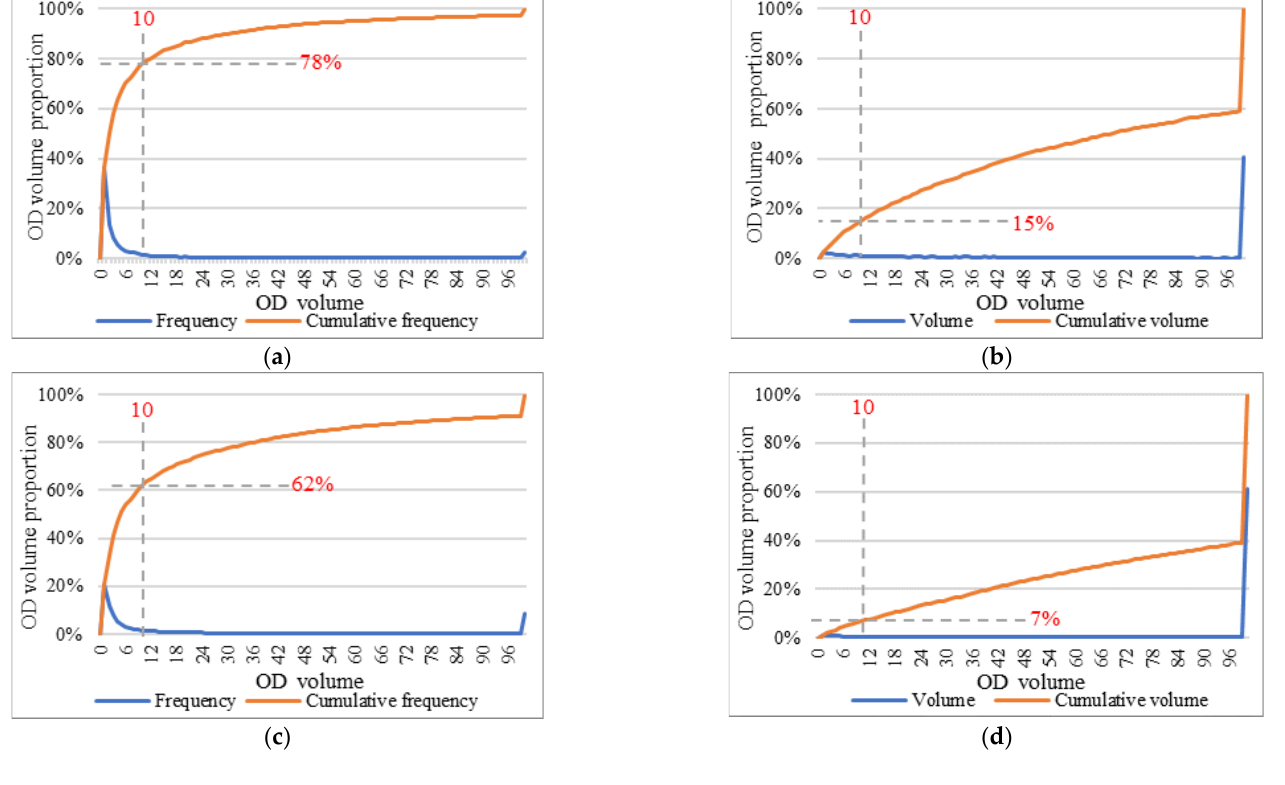
Figure 8. Distribution of taxi travel flow volume. ( a ) OD proportion distribution in Shenzhen. ( b ) Volume proportion distribution in Shenzhen. ( c ) OD proportion distribution in New York. ( d ) Volume proportion distribution in New York.